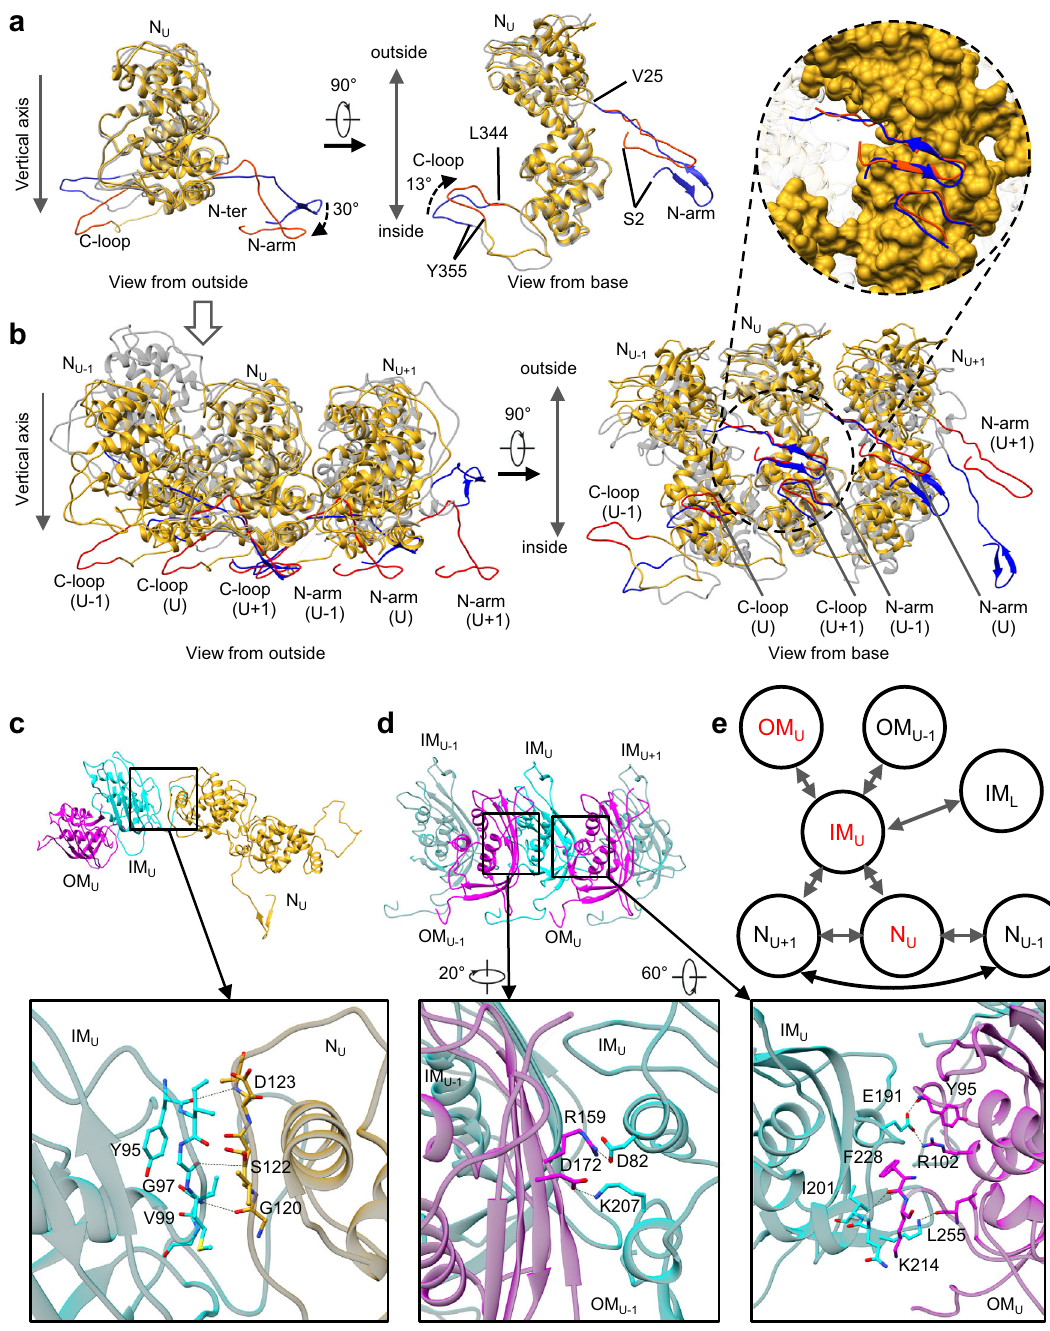
Fig. 3 | Analysis and illustrationof subunitsinteractions. a Superposition ofthe insituandcrystalstructuresofasingleNsubunit.Theinsitustructureiscoloredin goldenrod except for the N-arm and C-loop, in red, while the crystal structure is colored in transparent gray except for the N-arm and C-loop, in blue. b SuperpositionofthreeNsubunitsextendedfrom( a ).OnlythemiddleNsubunits are aligned.Inset: N U is shownassurface contour. c Interactionsbetween IMand N